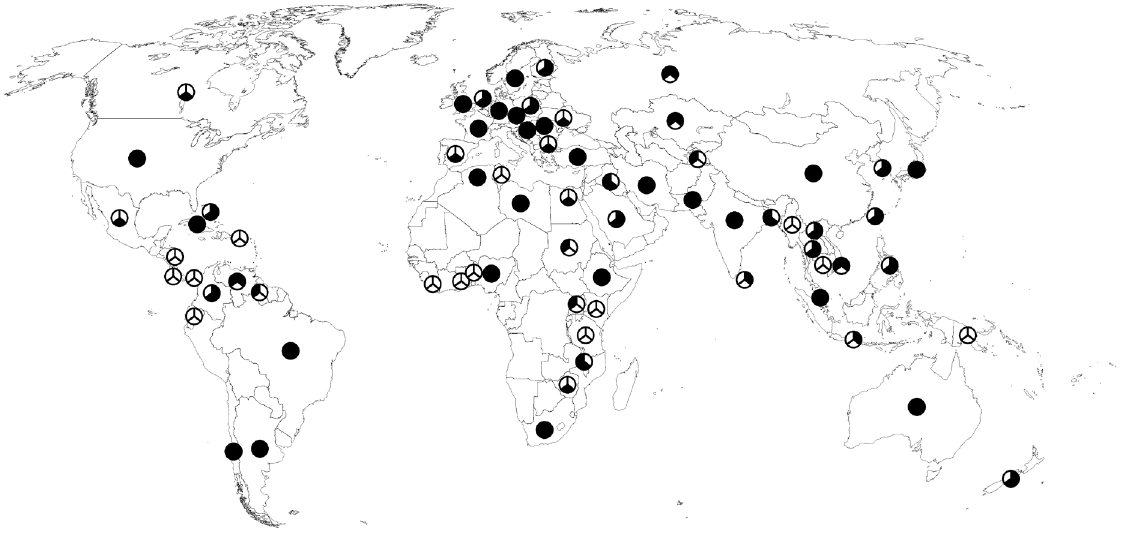
Fig. 1. Geographical distribution of three species of ischnoceran chewing lice parasitizing wild and domestic chicken ( Gallus spp). Each circle is divided into three sectors, representing the three louse species: upper left = Goniodes gigas (Taschenberg, 1879); upper right = Goniodes dissimilis Denny, 1842; lower = Goniocotes gallinae (De Geer, 1778). Black sectors indicate that this louse species is known from this country, whereas hollow sectors indicate that we have found no published records of this species in this country. Presence of the three species of chewing lice in a country is based on the reports summarized in Table